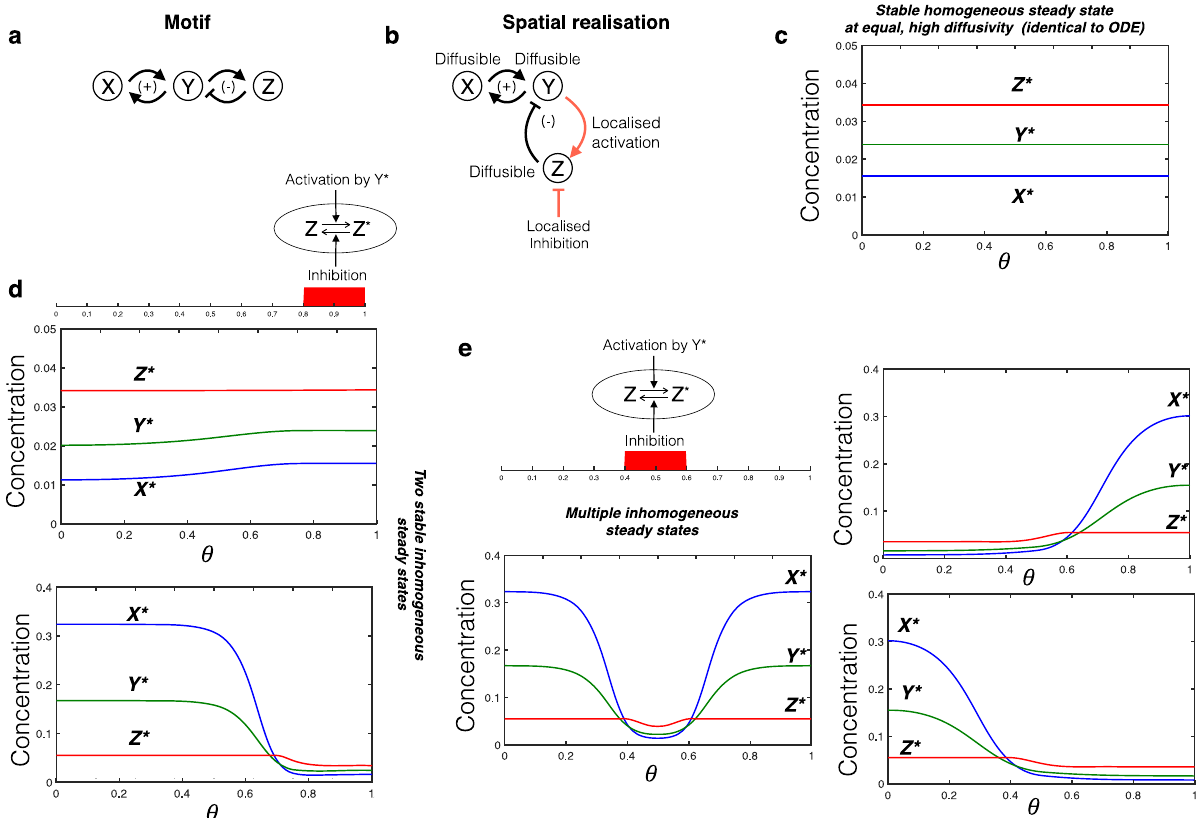
Fig. 4 Localisation-induced instability. a Motif under consideration: activator-inhibitor type motif where X is the activator and Z the inhibitor. b Schematic of spatial realisation: both forward and backward reactions at node Z are co-localised (the spatial domain has closed boundaries). c This localisation allows the system to have a homogeneous steady state, exactly equivalent to the ODE steady state. However, the homogeneous steady state may not be stable, and the system can exhibit multiple stable inhomogeneous steady states. Blue, green and red curves denote X * , Y * and Z * respectively in ( c – f ). d When the localised sub-domain is adjacent to a boundary, the system can have two co-existing inhomogeneous steady states, one where X and Y output are high outside the localised sub-domain, and another where they are low. e With the localised sub-domain located symmetrically with respect to boundaries, the system can exhibit multiple inhomogeneous steady states, including two symmetry-broken steady states where the X and Y output are high in one part of the domain and low in the other (right column), as well as symmetric steady states (left